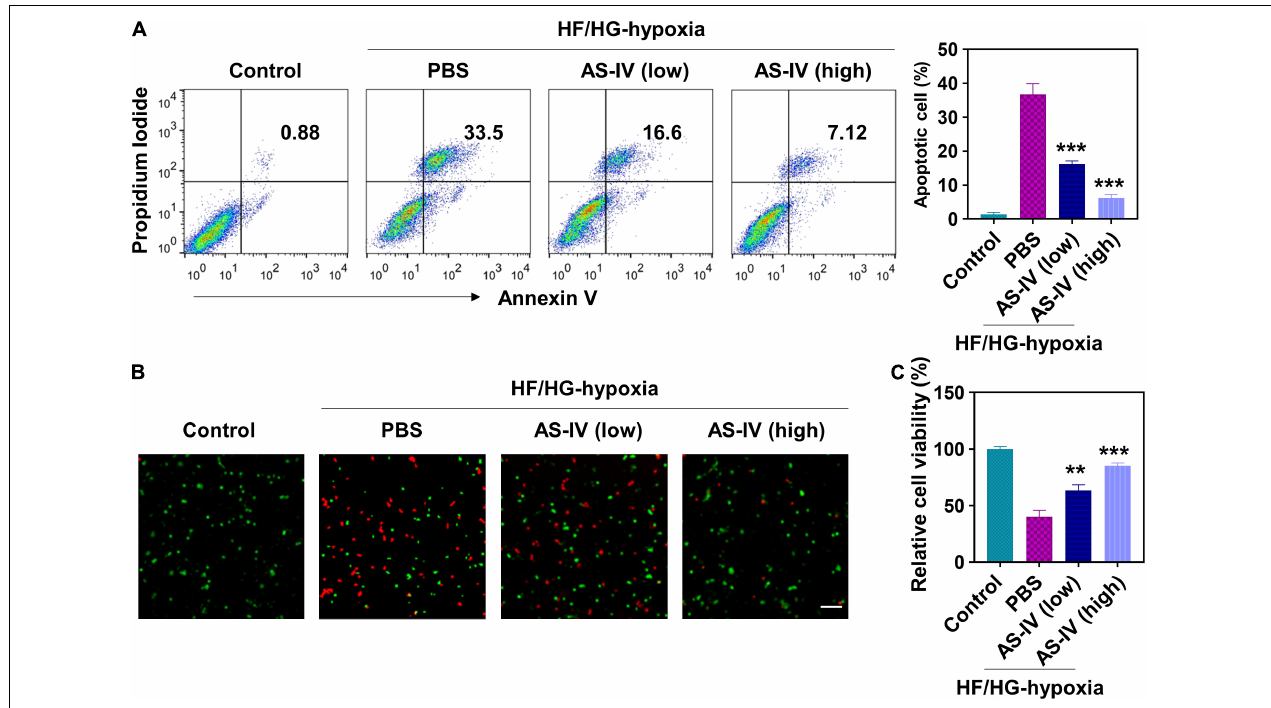
FIGURE 1 | Effect of astragaloside IV (AS-IV) on high glucose/high fat and hypoxia-induced apoptosis in H9c2 myocytes. To mimic the pathological condition with high glucose and high fat (HG/HF), H9c2 myocytes were cultured in HG/HF medium for 12 h followed by hypoxia for 2 h. Then H9c2 myocytes were treated with phosphate-buffered saline (PBS) or AS-IV solution (10 or 50 ng/ml). HG/HF medium was maintained during AS-IV treatment. Cell apoptosis and proliferation were examined 48 h later. (A) Cell apoptosis was detected by flow cytometry after staining with propidium iodide (PI) and Annexin V-FITC. Data represent means ± standard deviation (SD). *** p < 0.001, versus PBS group, n = 3 biologically independent samples. (B) Fluorescence images of live/dead H9c2 myocytes after AS-IV treatment. Cell viability was detected using LIVE/DEADTM Viability/Cytotoxicity Kit. Live and dead cells were stained as green and red. Scale bar = 50 µ m. (C) Cell viability was examined via Cell Count Kit-8 assay. Data represent means ± SD. ** p < 0.01; *** p < 0.001, versus the PBS group, n = 3 biologically independent